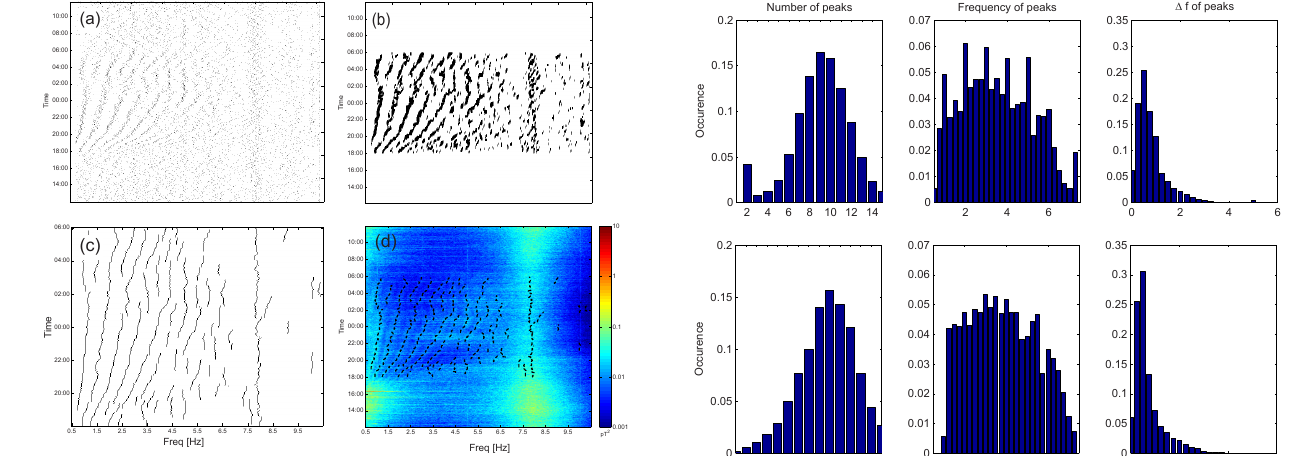
Figure 4. Histograms of the number of fringes (left), frequency lo- cation (middle) and frequency interval ( 1f ) (right) for all 525 days (upper) and 152 selected “good” days (lower) from September 2012 to February 2014. Fringes with f > 6 . 5Hz are